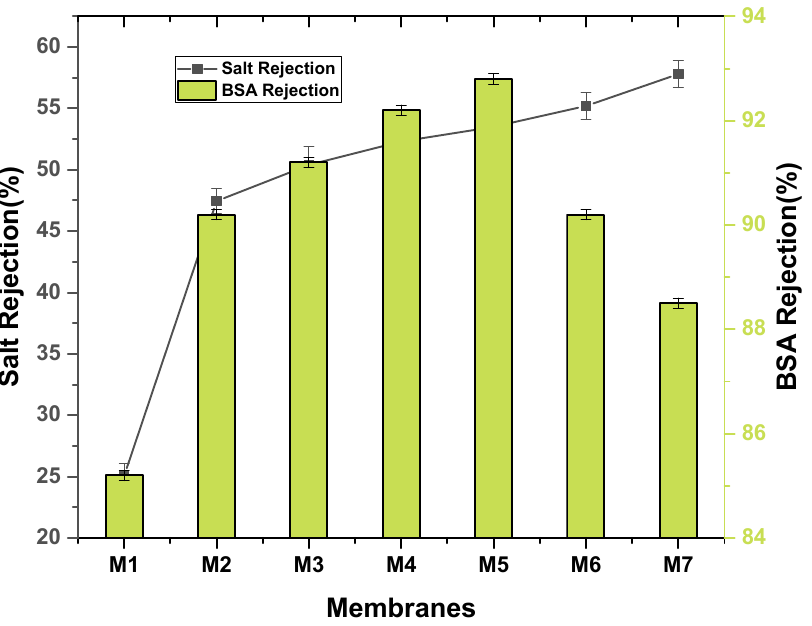
Figure 10. BSA and salt rejection of nanocomposite membranes.